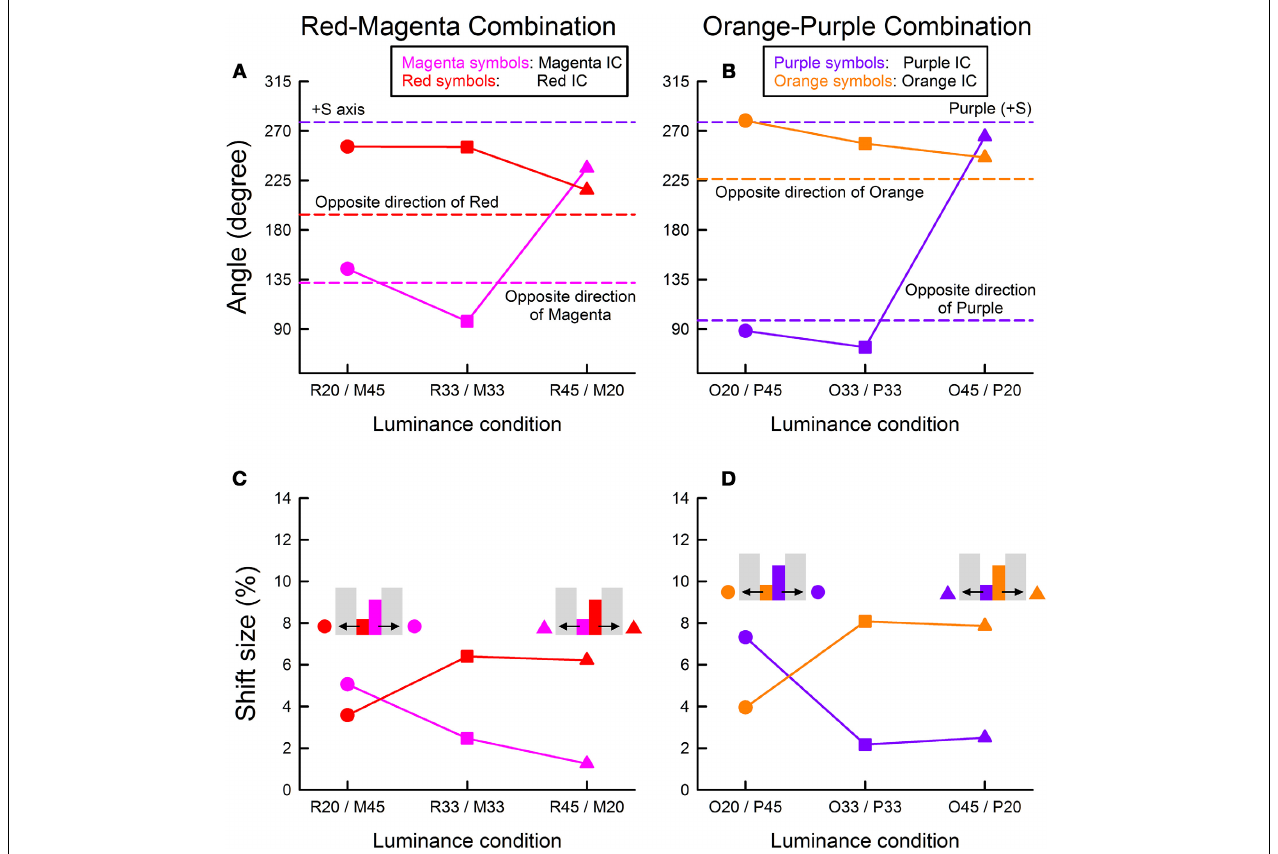
FIGURE 8 | Color direction and shift size of the cancelation settings as a function of the contour luminance condition. (A,C) The results for the red and magenta combination, and (B,D) those for the orange and purple combination. Upper panels show the results of color direction analysis, whereas lower panels show the results of shift size